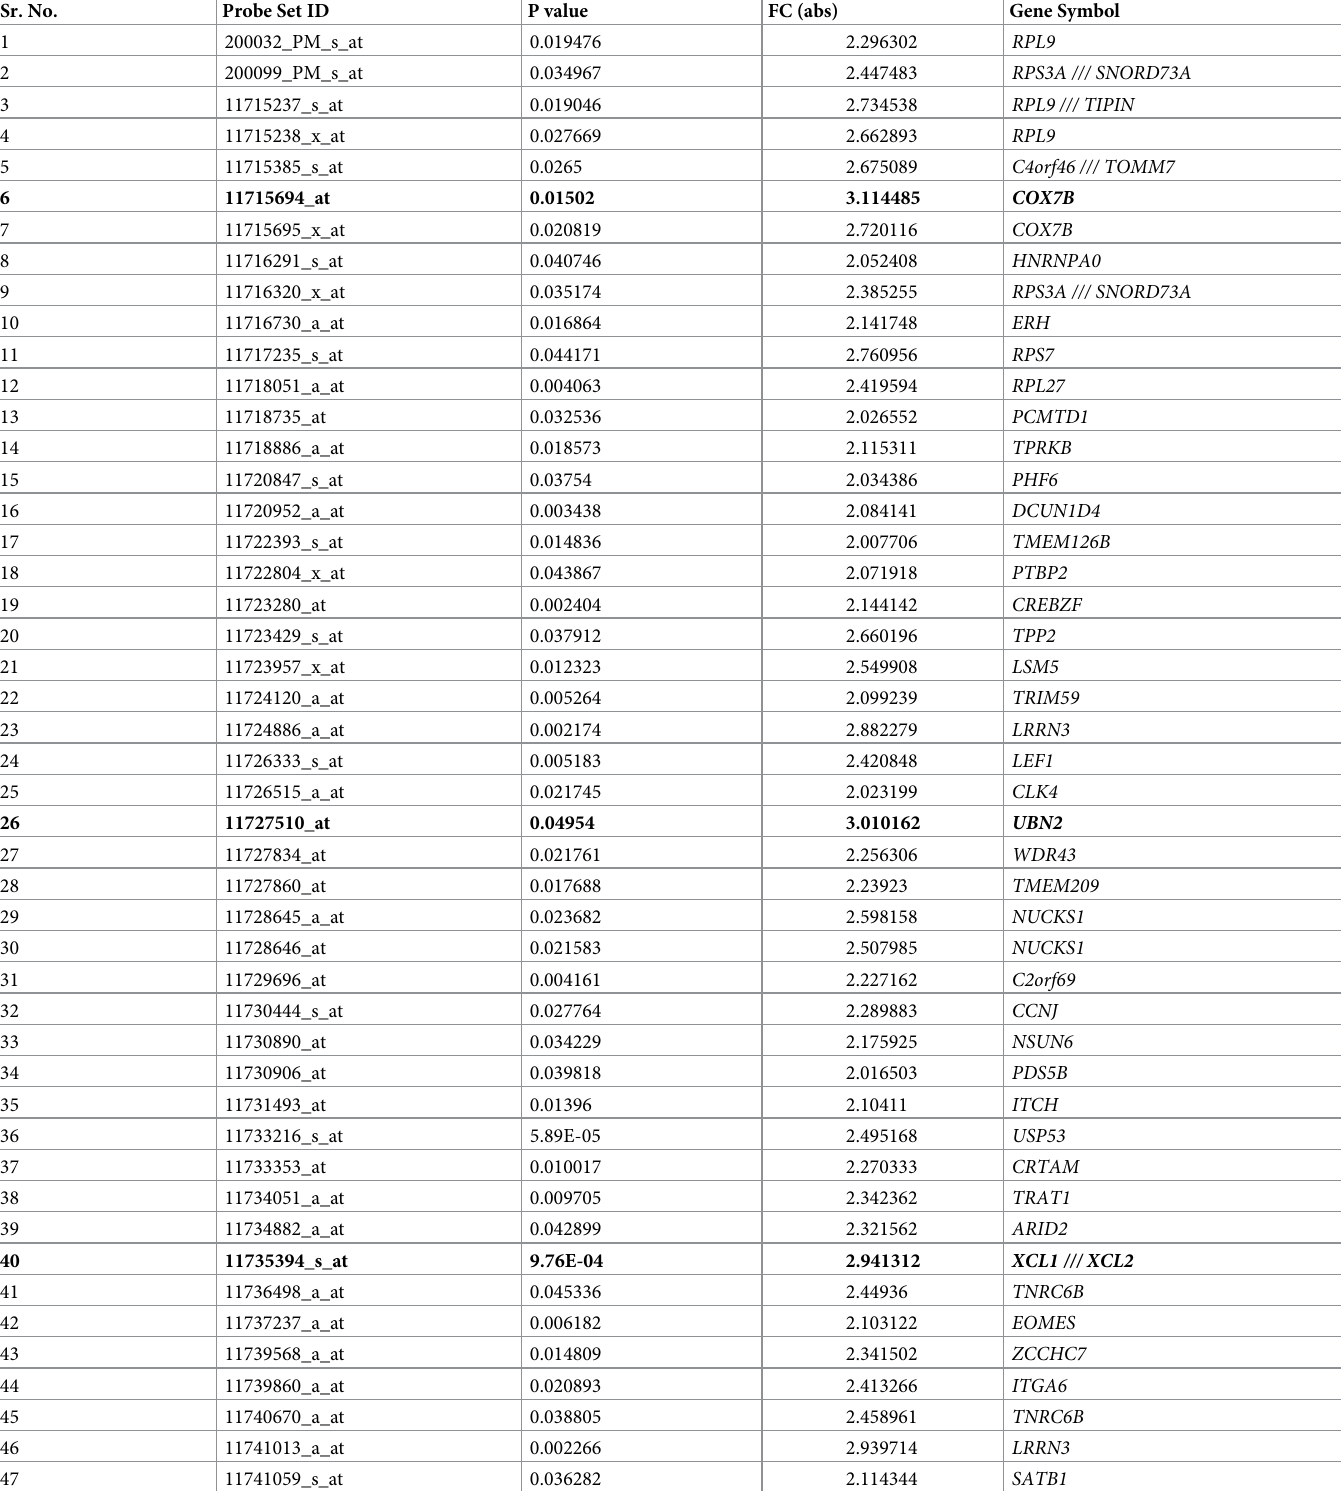
Table 2. Summary of genes differentially up-regulated in ART-IF as compared to ART-R. Sr.